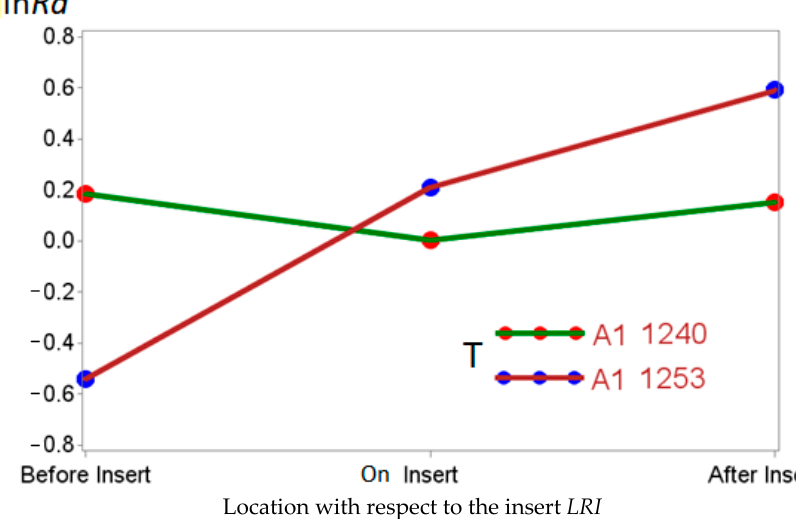
Figure 8. ln Ra interaction between type of tool and the location with respect to the insert T*LRI .